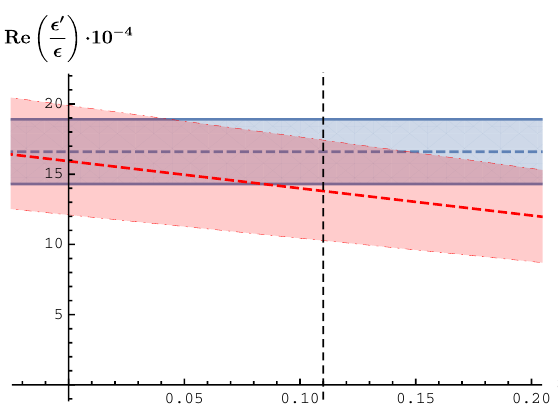
Figure 3 . SM prediction for Re ( (cid:15) 0 =(cid:15) ) (red dashed line) as a function of (cid:10) e(cid:11) . The red band has been obtained adding all sources of uncertainty in quadrature for a (cid:12)xed value of (cid:10) e(cid:11) . The vertical dashed line indicates the central value of (cid:10) e(cid:11) in (7.1) and the blue horizontal band the measured value of Re ( (cid:15) 0 =(cid:15)